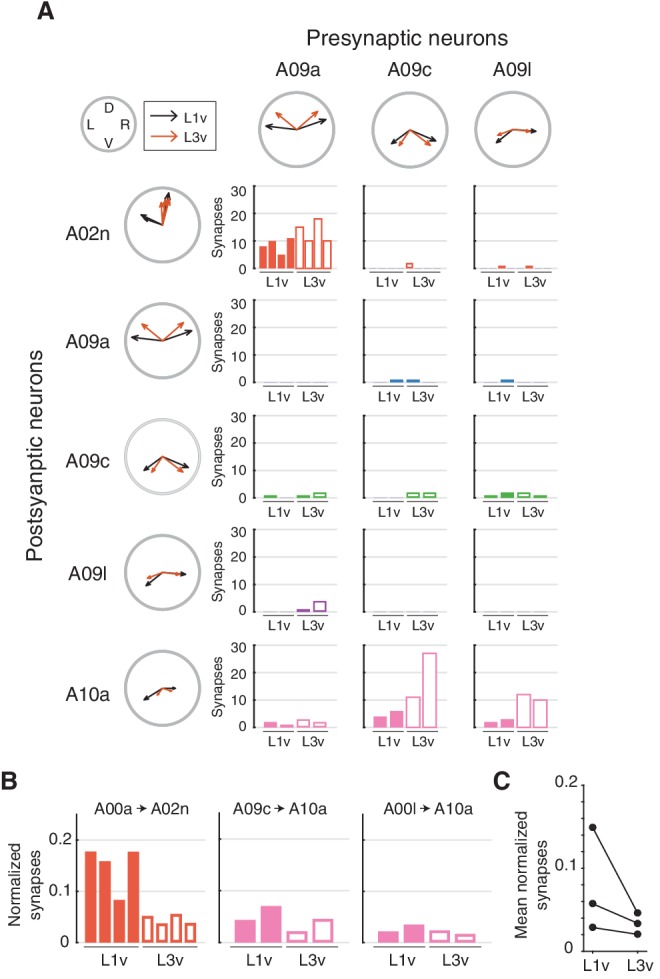
Topographically structured feed-forward connectivity between mdIV-related LNs.(A) Synaptic connectivity between LN cell types in the L1v (solid bars) and L3v (empty bars). Each bar plot depicts the number of synapses each cell of the post-synaptic cell type (rows) receives from all cells of the pre-synaptic cell type (columns). Cell types are labeled with spatial receptive fields from Figure 3H. Each cell type that was strongly connected in the L1v was again connected in the L3v. Strikingly, the dorsally oriented A09a targeted the dorsally oriented A02n and the ventrolaterally oriented A09c and A09l targeted the ventrolaterally oriented A10a, suggesting feed-forward topographic microcircuits. (B) Normalized synaptic connectivity between LNs. (C) Mean strength, measured as normalized synaptic inputs, for specific connections between cell types in the L1v and L3v. The number of data points is too small to make a statistical conclusion.